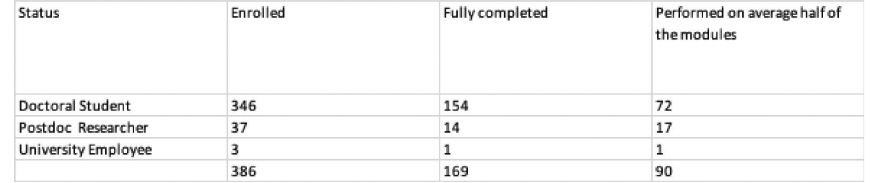
Table 2: Enrolled, fully completed, and (on average) approximately half the modules performed in 2019–2021